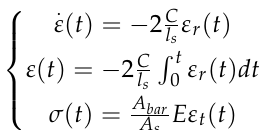
where ε r ( t ) and ε t ( t ) are the reflected and transmitted strains measured by strain gauges on the compression bars, respectively. E , C , and A bar are the modulus of elasticity, elastic wave velocity, and cross-sectional area of the incident and transmitted bars, respectively. A s and l s are the cross-sectional area and length of the specimen, respectively. In addition, in uniaxial compression experiments, engineering strains and stresses can be converted to real strains and stresses using Equation (3).